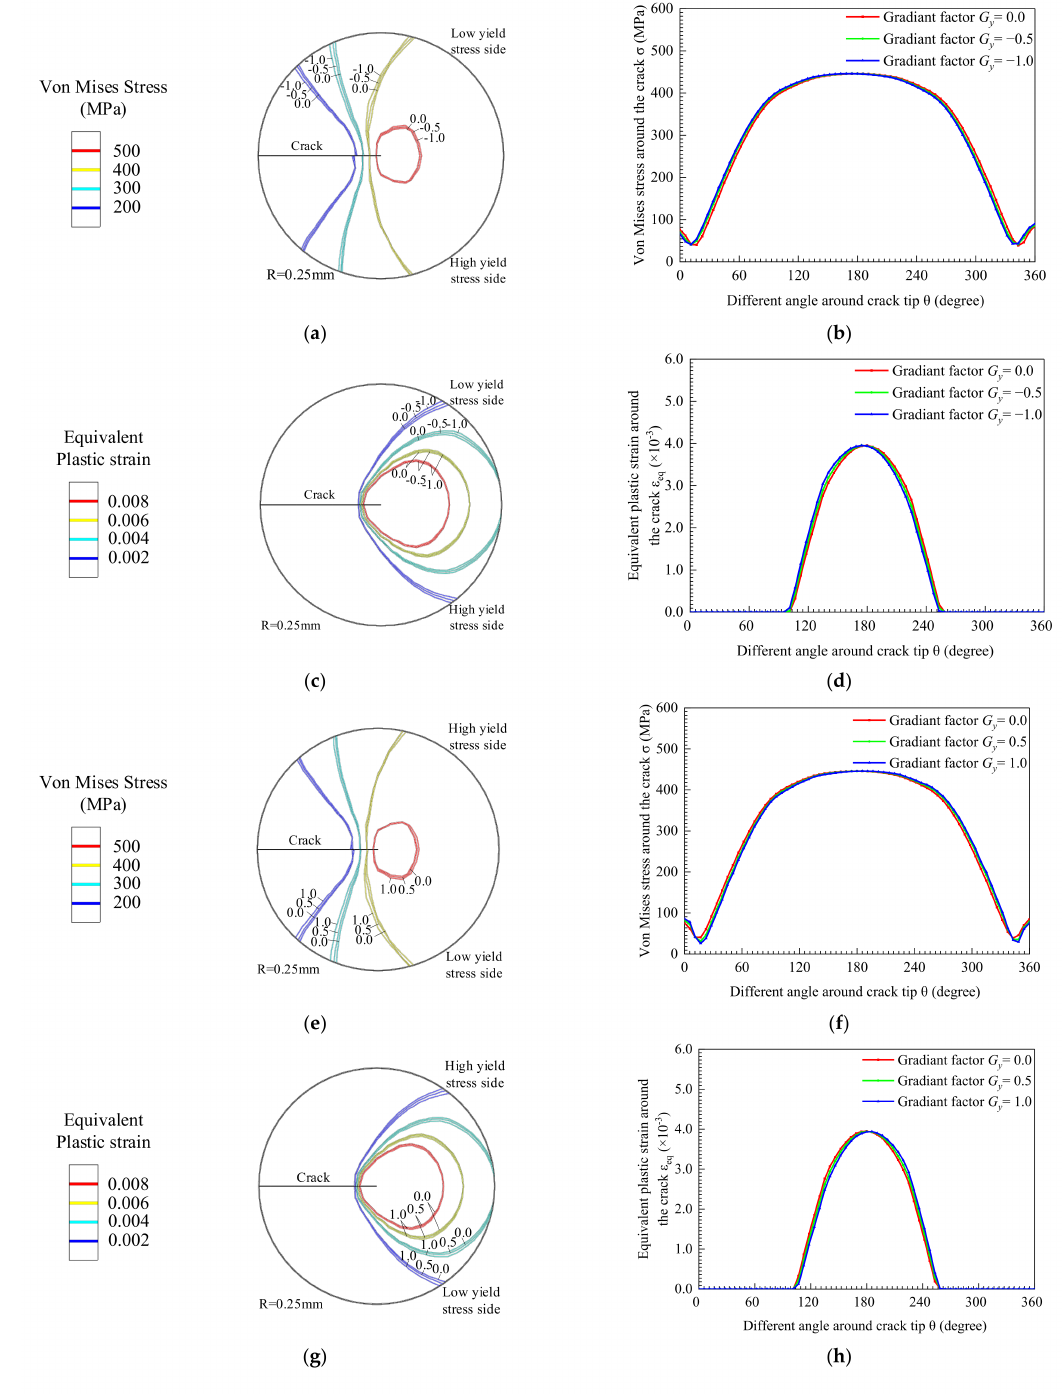
Figure 16. Mechanical field of the crack tip at the initial crack perpendicular to the direction of yield strength change. ( a ) G y < 0 Von Mises stress contour, ( b ) Von Mises stress around crack tip, ( c ) Equivalent plastic strain contour and ( d ) Equivalent plastic strain around crack tip. ( e ) G y > 0 Von Mises stress contour, ( f ) Von Mises stress around crack tip, ( g ) Equivalent plastic strain contour and ( h ) Equivalent plastic strain around crack tip. On the contrary, when G y > 0, the material gradually changes from high yield strength to low yield strength in the y -direction. The mechanical fields turn to the low yield strength side. As G y increases, the deflection of the mechanical field is greater toward the low yield strength